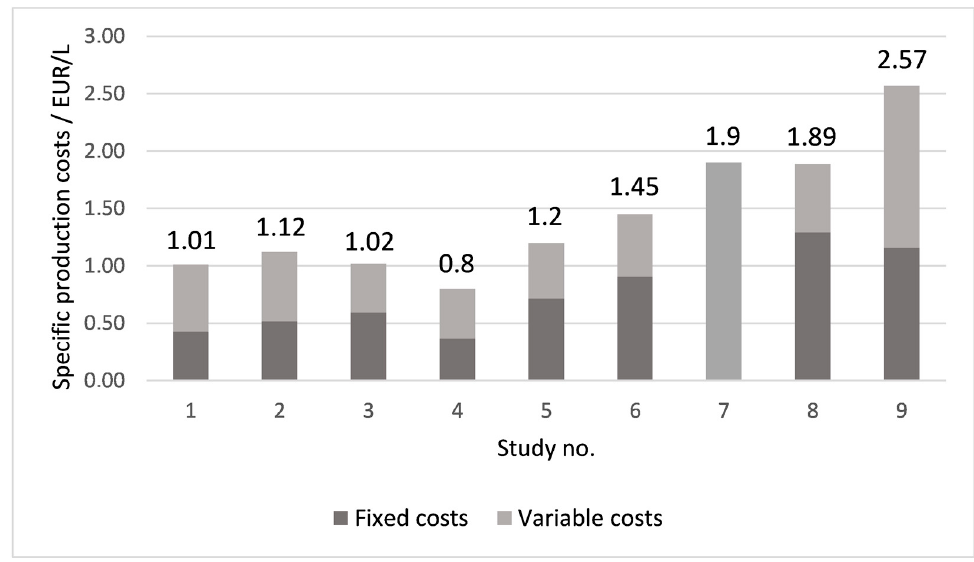
Figure 4. Specific production costs and their composition by fixed and variable costs. Table 5. Economic parameters and cost contributions of the BtL cost evaluation; Colors of the pie chart: light blue: capital cost; orange: maintenance; grey: tax & insurance; yellow: personnel; blue: overhead; green: biomass; dark blue: materials; brown: utilities.